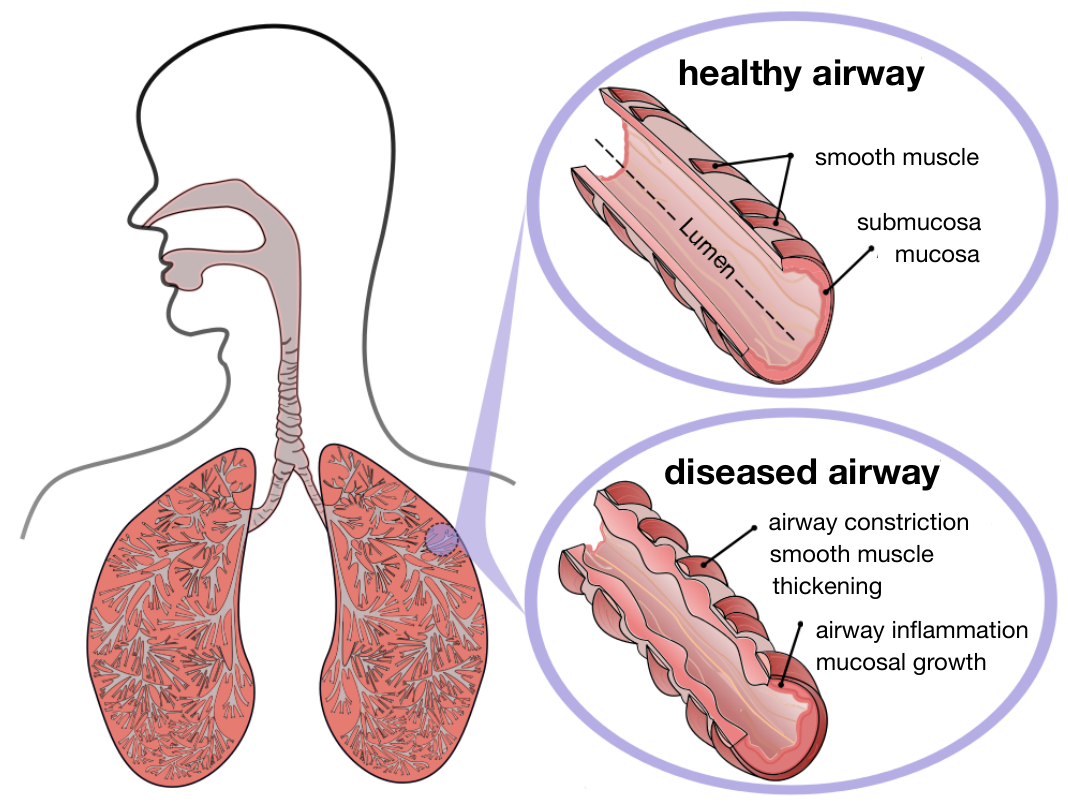
Figure 2. Schematic of the lungs. The trachea, the root of the respiratory tree, branches into two main bronchi, which enter the left and right lungs. In the lungs, the bronchial tree continues to branch in humans into 23 to 27 generations, yielding approximately 17 million branches. The final generation of terminal bronchioles opens into the alveolar space, where gas transfer occurs. Airway wall remodeling affects the small airways between the fourth and 14th generation. Healthy small airways are less than 2 mm in diameter, non-cartilaginous and compliant. In chronic lung disease, the small airways experience smooth muscle thickening and mucosal growth, resulting in progressive airflow